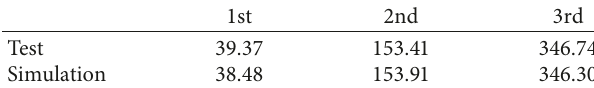
Table 3: Natural frequency of the beam (unit: Hz).